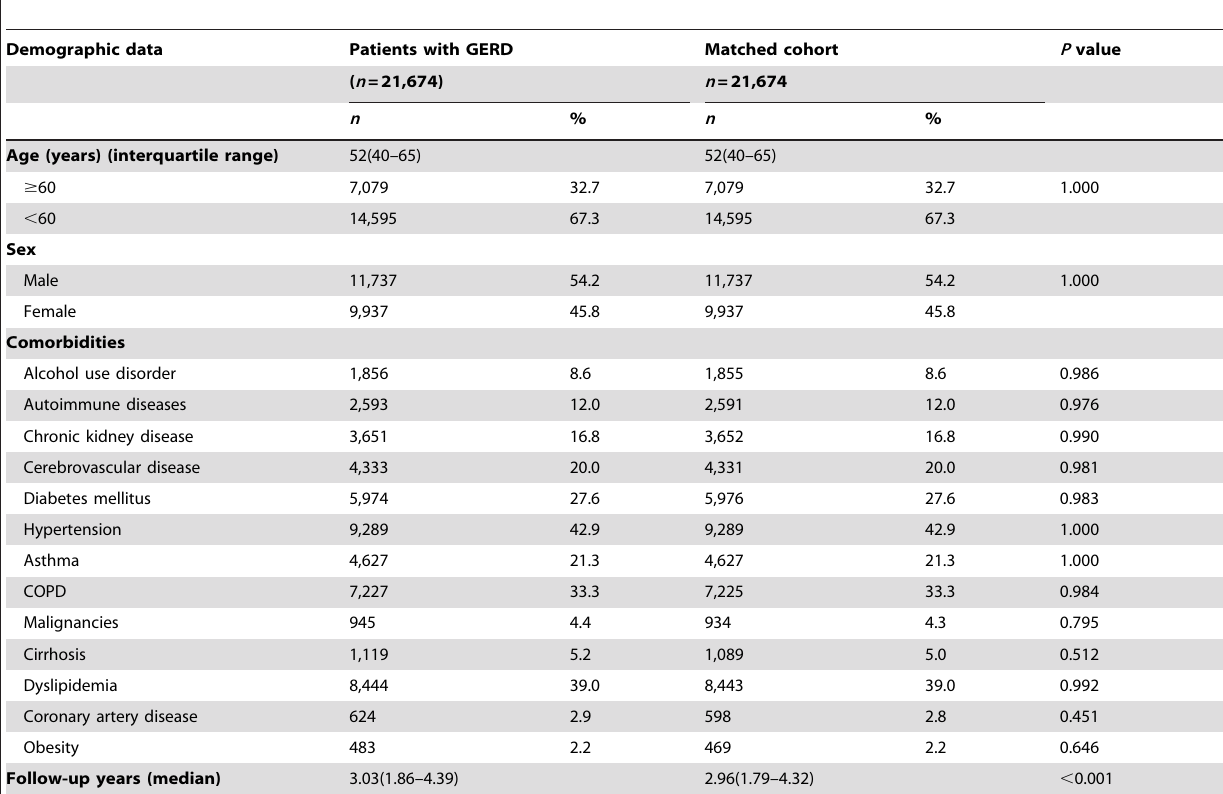
Table 1. Baseline characteristics of patients with gastroesophageal reflux disease (GERD) and matched cohort.